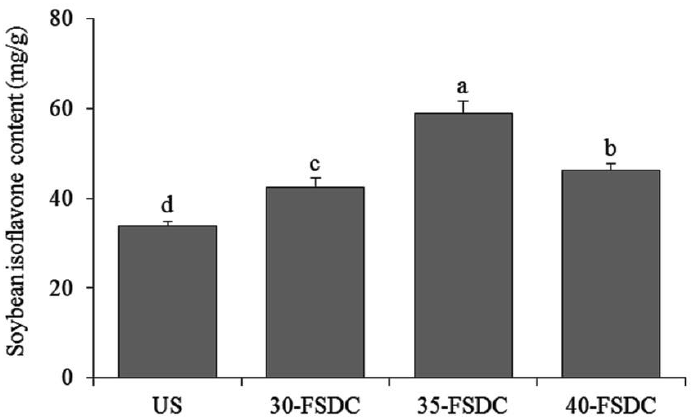
Figure 3. Soybean isoflavone contents of Shuidouchi fermented at different temperatures. a–c Mean values with different letters indicate significant differences ( p < 0.05). US: unfermented soybean; 30-FSDC (fermented Shuidouchi): 30 °C fermented Shuidouchi; 35-FSDC: 35 °C fermented Shuidouchi; 40-FSDC: 40 °C fermented Shuidouchi.